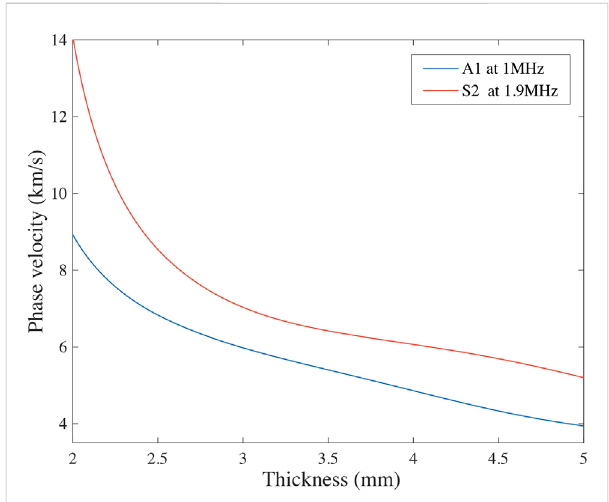
FIGURE 1 The phase velocity variation of the A1 and S2 modes with the plate thickness at some speci fi c